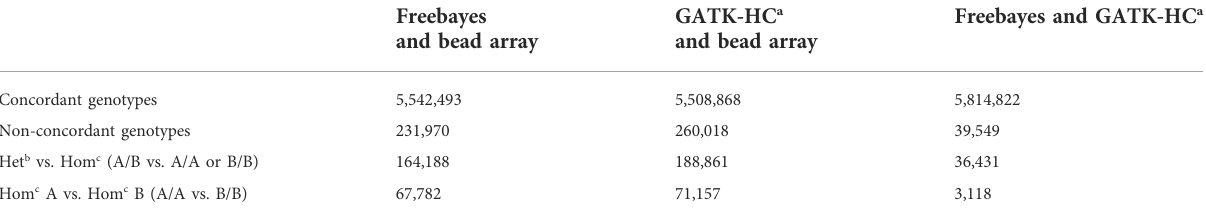
TABLE 3 Total number of concordant and non-concordant SNPs between the variant callers and bead array data for all the animals genotyped.